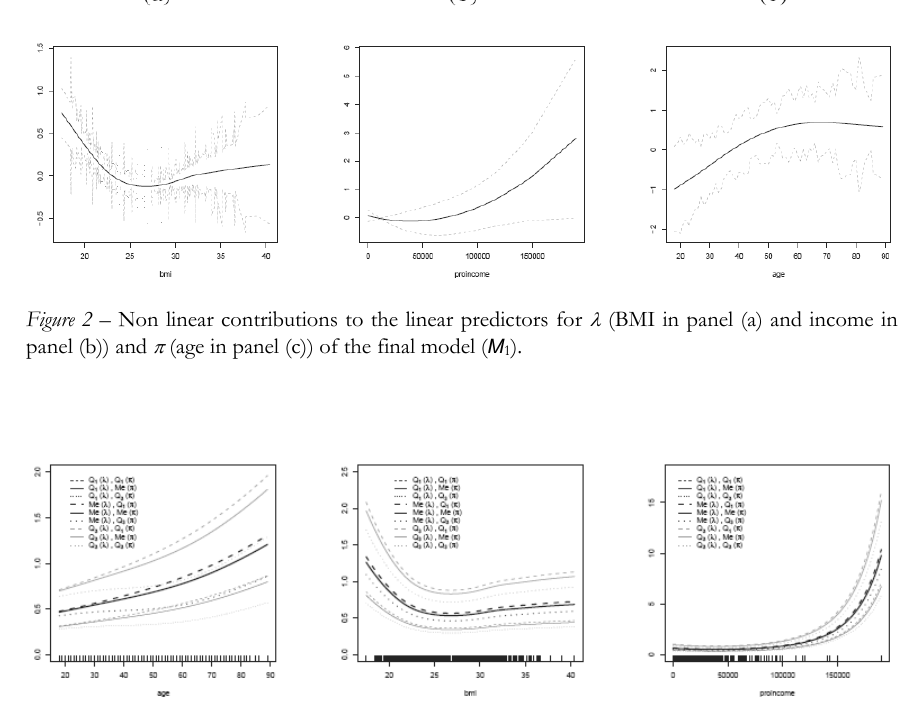
Figure 3 – Estimated conditional expectation of Y according to the final model ( M 1 ).